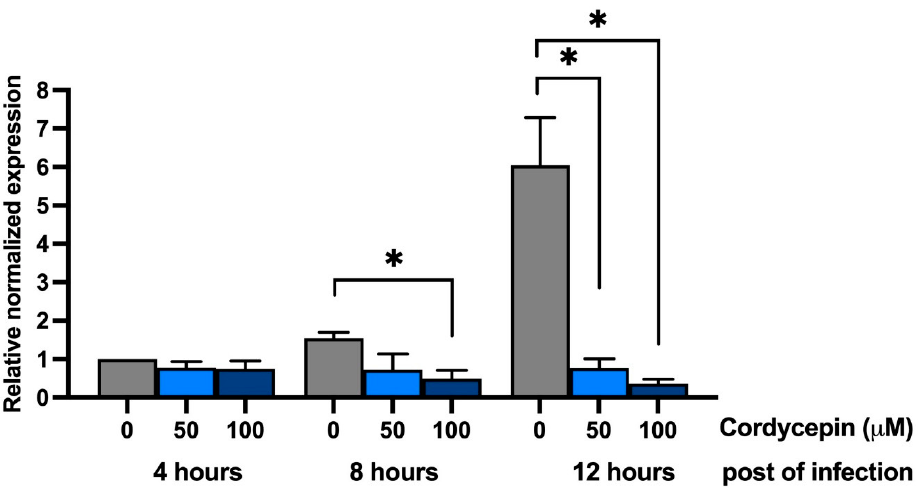
Figure 3. Effect of cordycepin on DENV2 RNA synthesis. Vero cells were infected with DENV2 and treated with cordycepin at concentrations of 0, 50, and 100 μ M 4, 8, and 12 h postinfection. DENV2 RNA was quantitated by real-time reverse transcription polymerase chain reaction (RT-PCR). (* indicates p < 0.05.)